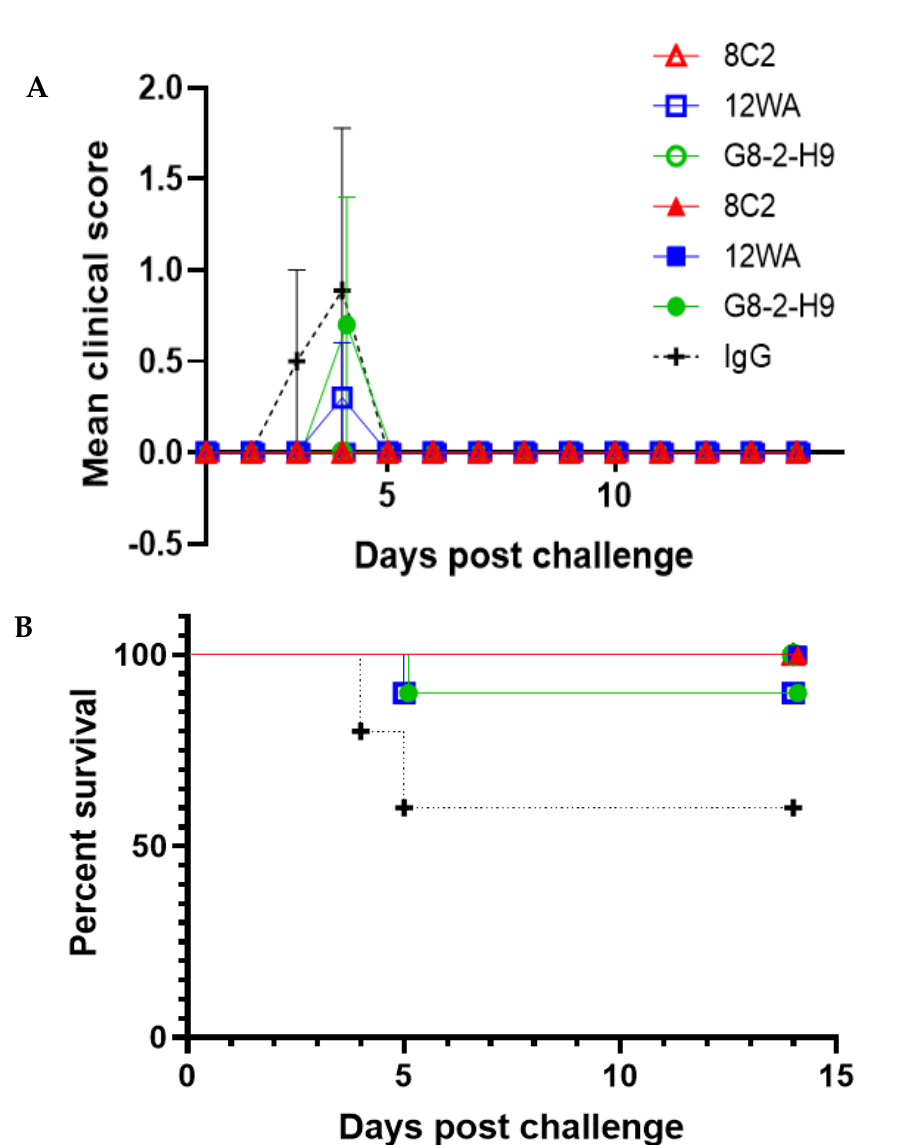
Figure 4. Evaluation of anti-EEEV NAb efficacy in a pre-exposure prophylaxis setting. Mean clinical score ( A ) and mortality rate ( B ) of BALB/c mice inoculated with candidate anti-EEEV NAbs at a dose of 2.5 mg/kg (empty symbols) or 10 mg/kg (filled symbols) via the IP route 24 h prior to a lethal exposure of EEEV PE6 via the aerosol route. Any deceased mice were assigned the maximum score observed in this study ( n = 10, except for the non-specific IgG control group, where n = 5). Error bars indicate the standard error of the mean.